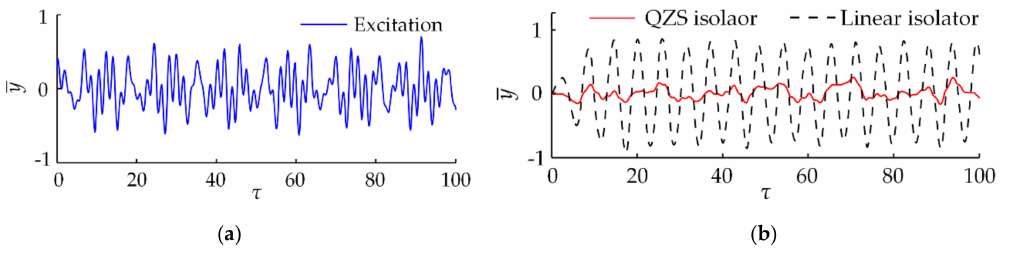
Figure 14. Time history under multi-frequency wave excitation. ( a ) displacement excitation; ( b ) displacement responses of QZS and equivalent linear isolators.